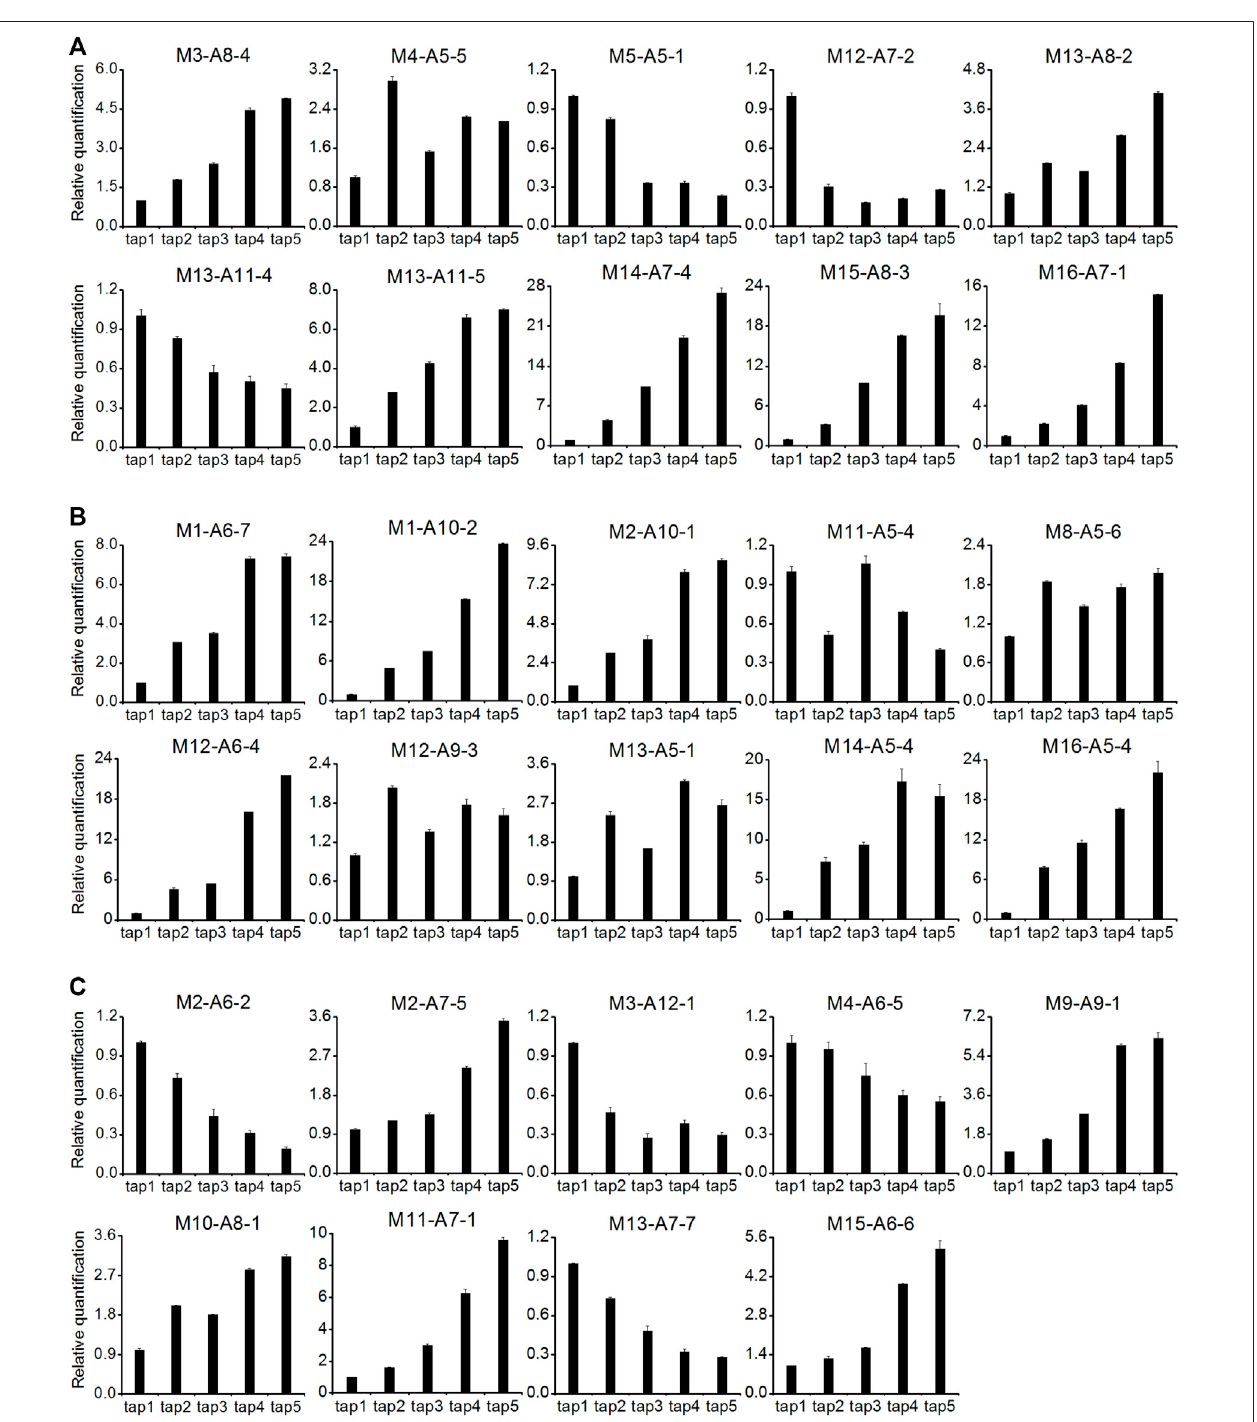
FIGURE4| qRT-PCRanalysisfor expression oflatexregeneration genesinthe latexofthe fi rst fi vetappings. (A) : primary metabolism pathway (ten DE-TDFs); (B) : rubber biosynthesis and regulation pathway (ten DE-TDFs); (C) : transporters and intracellular transport pathway (nine DE-TDFs). Except for M3-A8-4, M11-A5-4 and M16-A7-1, 26of the 29 DE-TDFs shows the results consistent with their originalcDNA-AFLP expression patterns and were presented here. All data were normalized to the expression level of HbYLS8 gene. Values are averages ± STDEV of three technical replicates. The latex samples of three individual trees were analyzed with similar patterns of expression, and one representative was